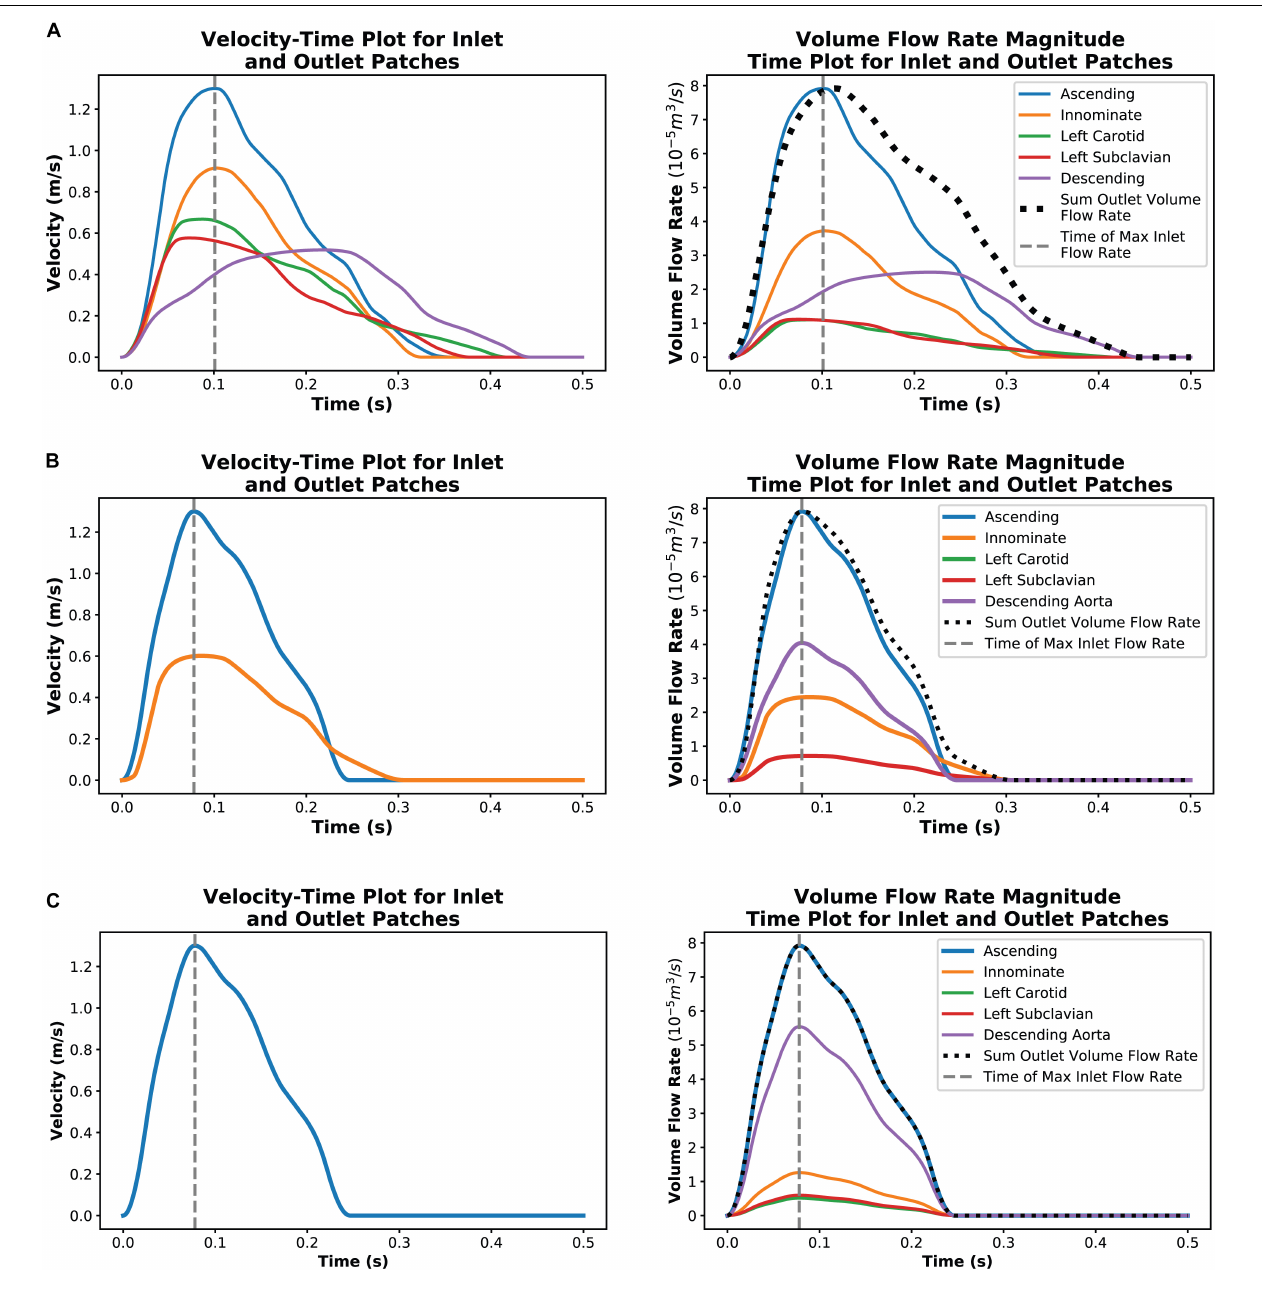
FIGURE 4 | Plots showing a single cardiac cycle of available velocity data for each case and the result of data processing to create volumetric flow rate plots at each outlet for case 1 (A) , case 2 (B) , and case 3 (C) .